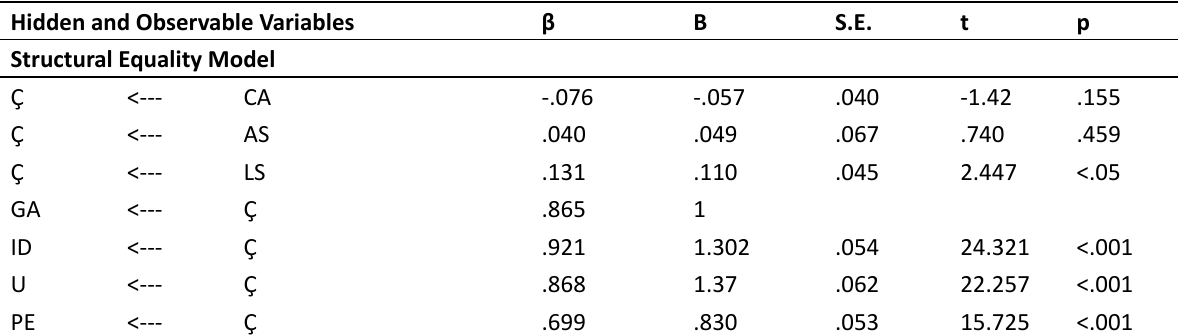
Table 4. Parameter estimates and coefficients for structural model Hidden and Observable Variables Structural Equality Model